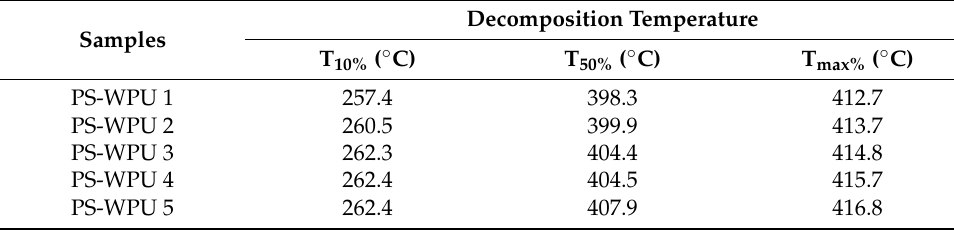
Figure 6. ( a ) TGA and ( b ) DTG curves of PS-WPU samples. Table 4. Thermal properties of PS-WPU samples.